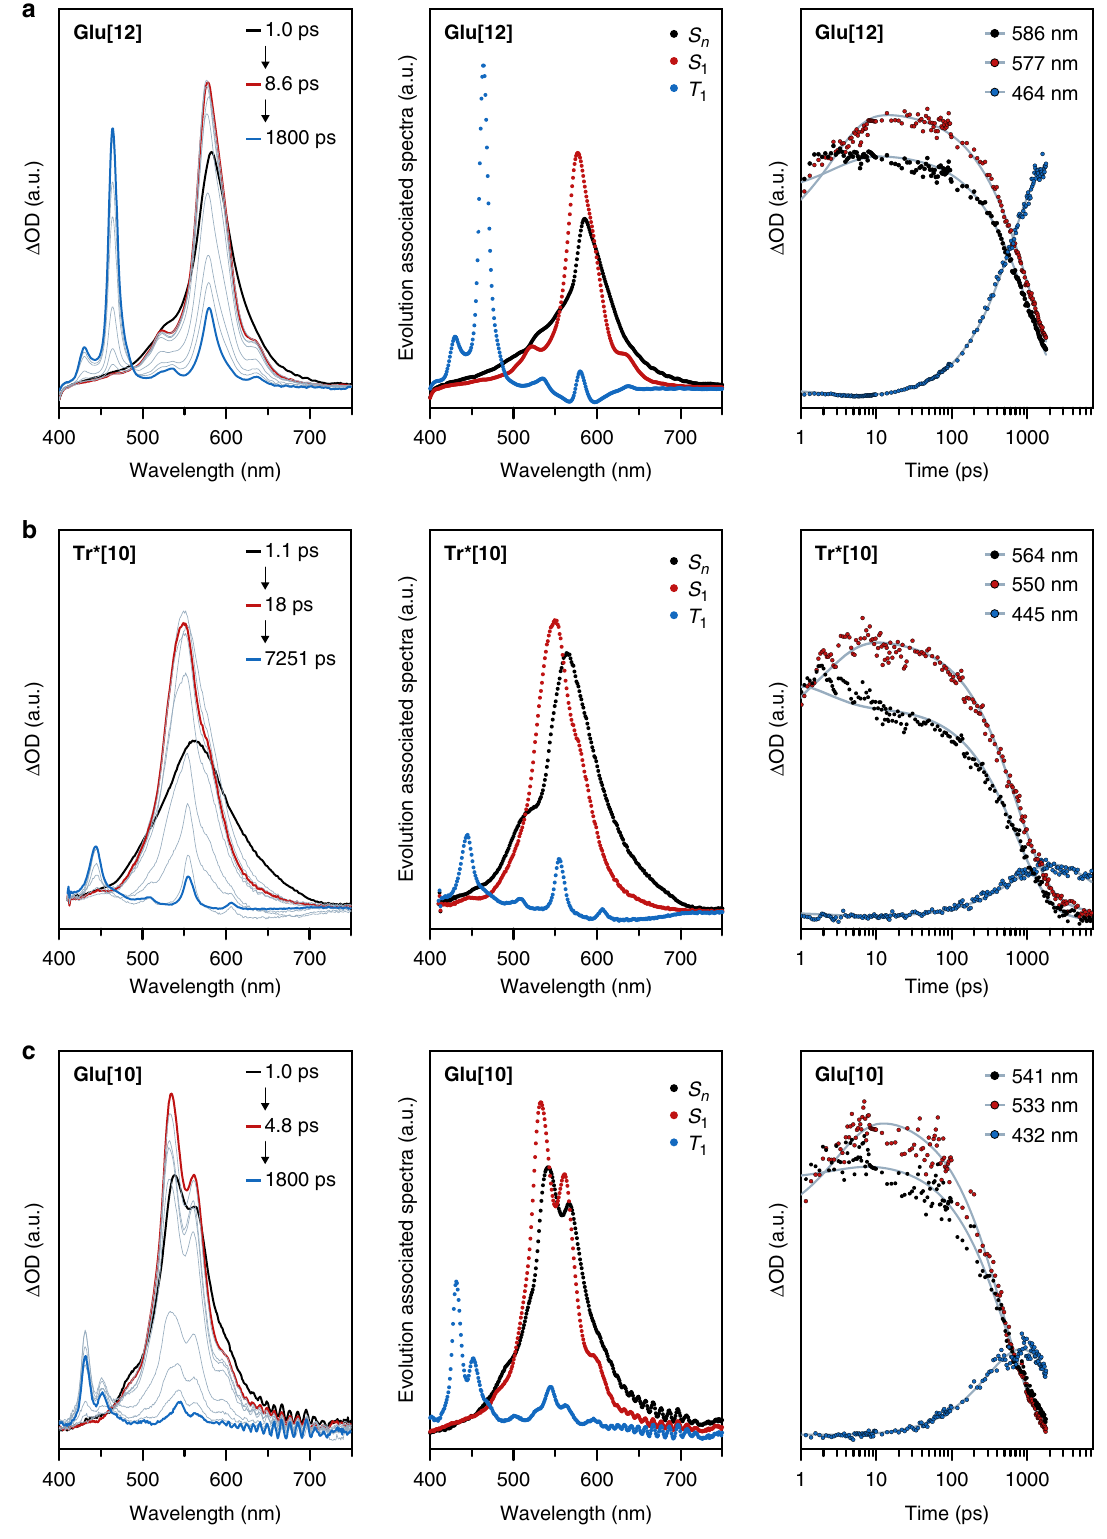
Fig. 3 Transient absorption spectroscopy and analysis. Selected transient absorption spectra ( fi rst column), evolution-associated spectra obtained from global analysis (second column), and characteristic dynamics with a fi t to the corresponding data (gray line, third column) of a Glu[12] (DCM), b Tr*[10] (hexane), and c Glu[10] (DCM). Source data are provided as a Source Data fi